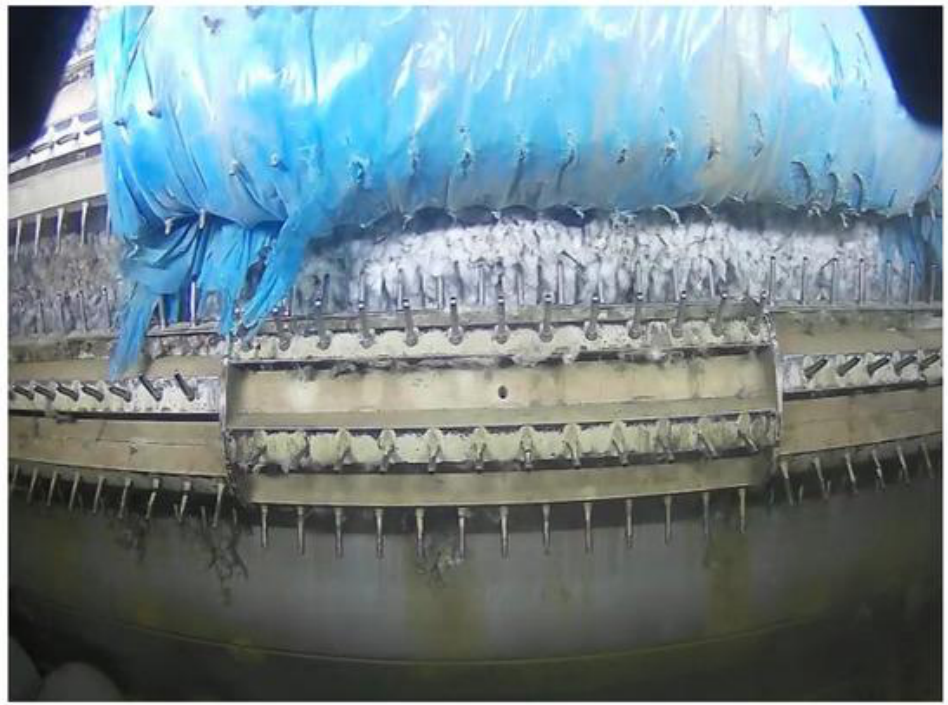
Figure 4. An example module cover trapped on dispersing cylinders of a cotton gin module feeder [73].